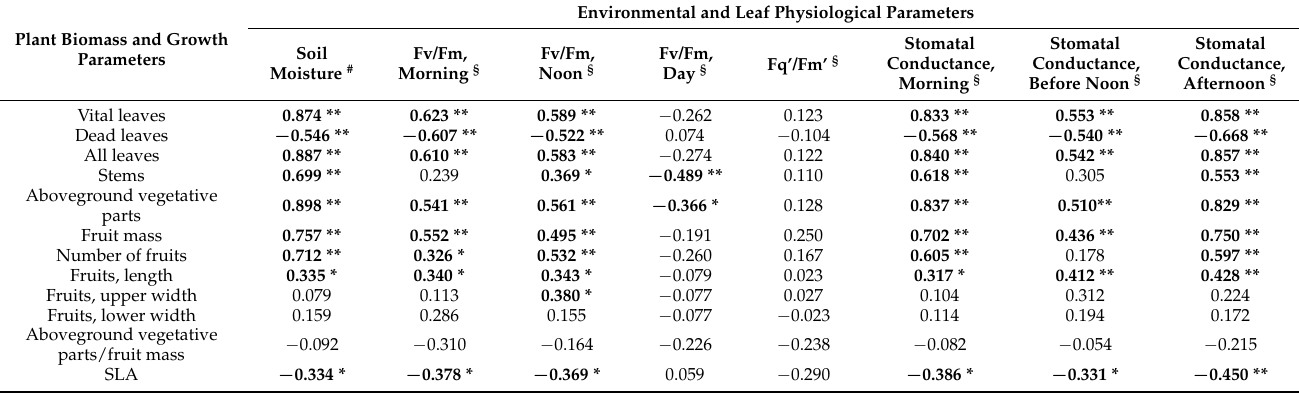
Table 4. Pearson’s correlation coefficients between plant biomass and growth parameters, and environmental and leaf physiological parameters for the cucumber plants in this